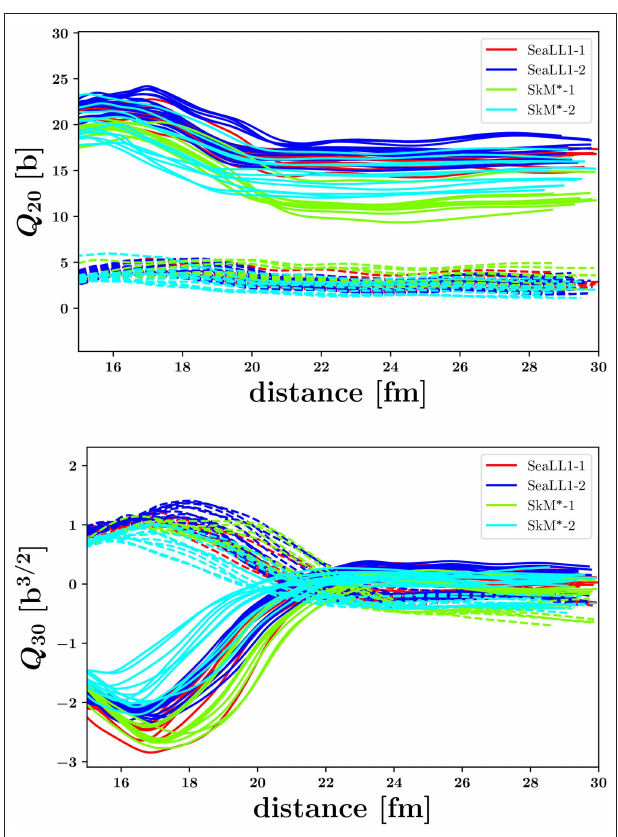
FIGURE 5 | The evolution of the quadrupole and octupole moments of the FFs as a functions of their separation after scission [ 17]. Different lines correspond to different initial conditions and different NEDFs, see Bulgac et al. [ 17] more details. The solid/dashed lines are for the light/heavy FFs, respectively. This figure is adapted from the results published in Bulgac et al. [ 17] under the Creative Commons CC BY license.